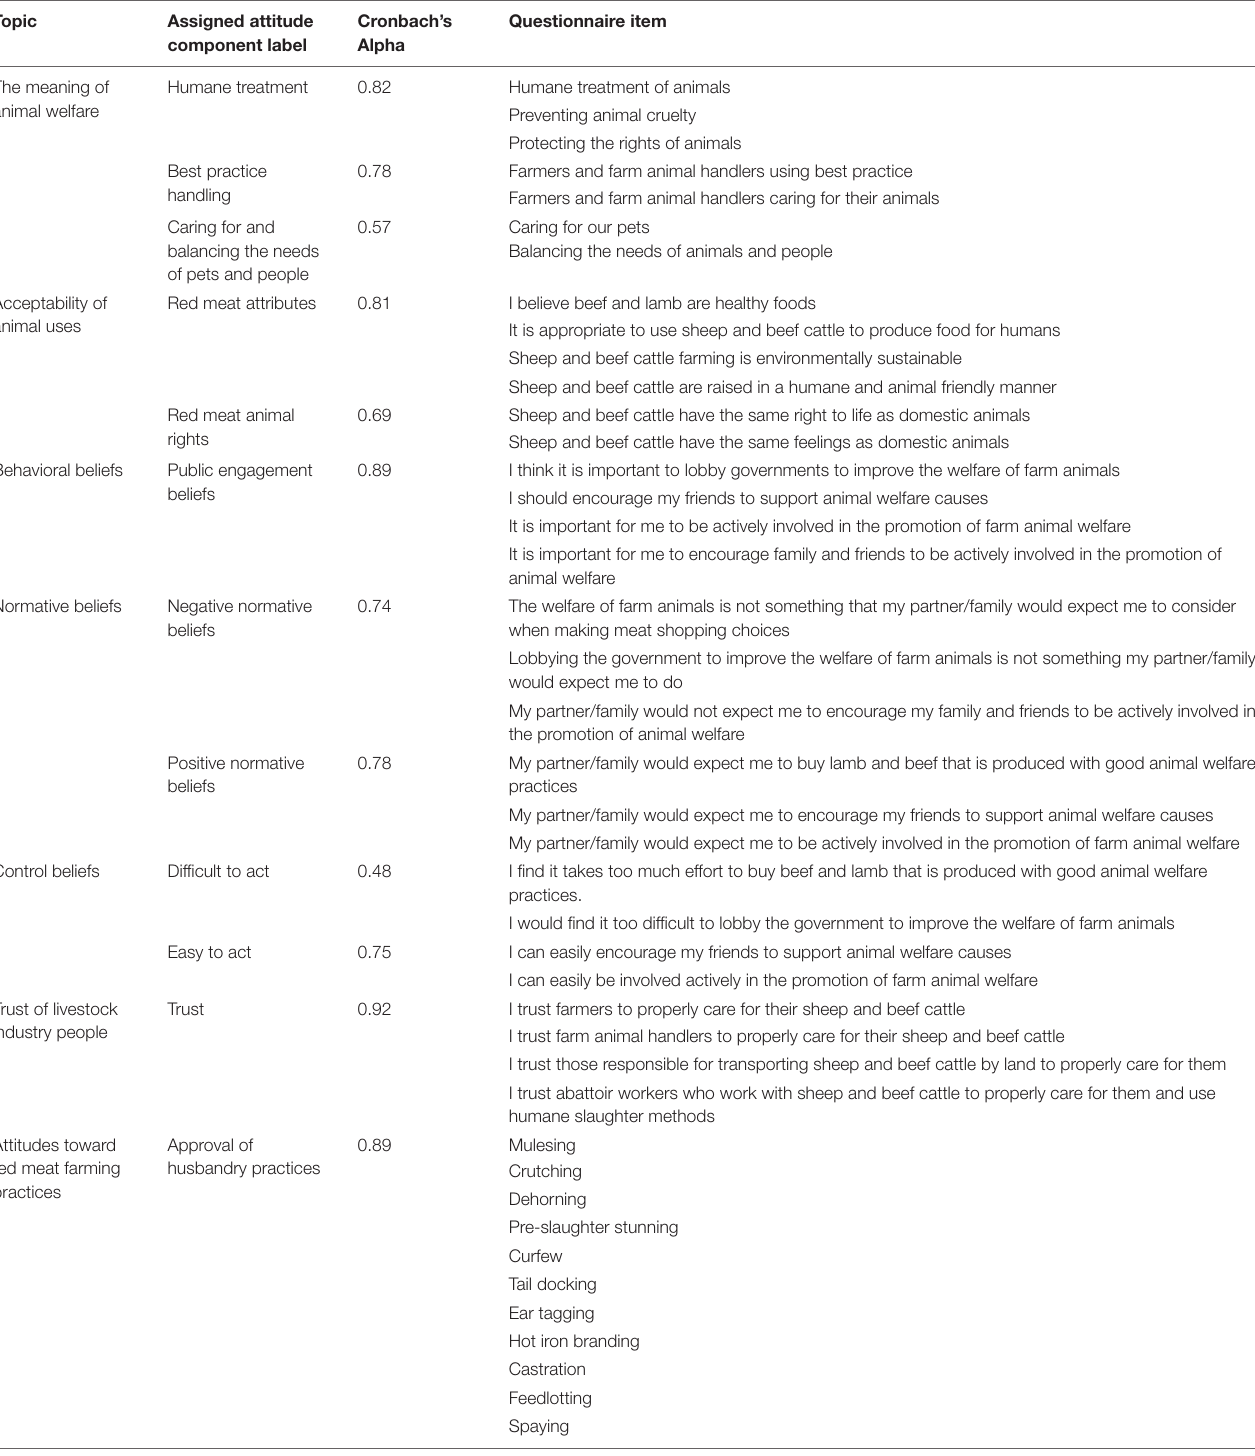
TABLE 2 | Components from the questionnaire grouped into composite scores, a high score indicating a positive attitude or strong agreement to the statements. Topic Assigned attitude Cronbach’s Questionnaire component label Alpha